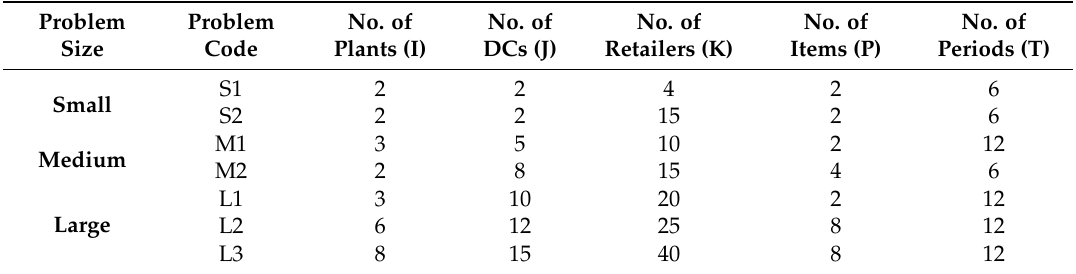
Table 2. Test problems size as suggested by